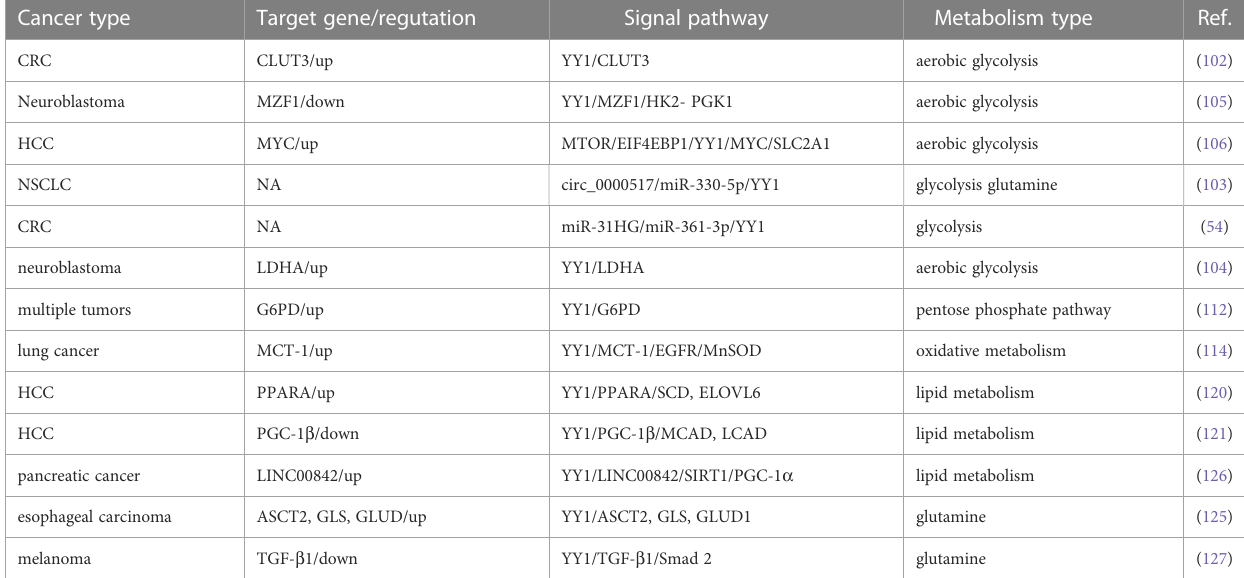
TABLE 4 The function and mechanism of YY1 on tumor metabolism. Cancer